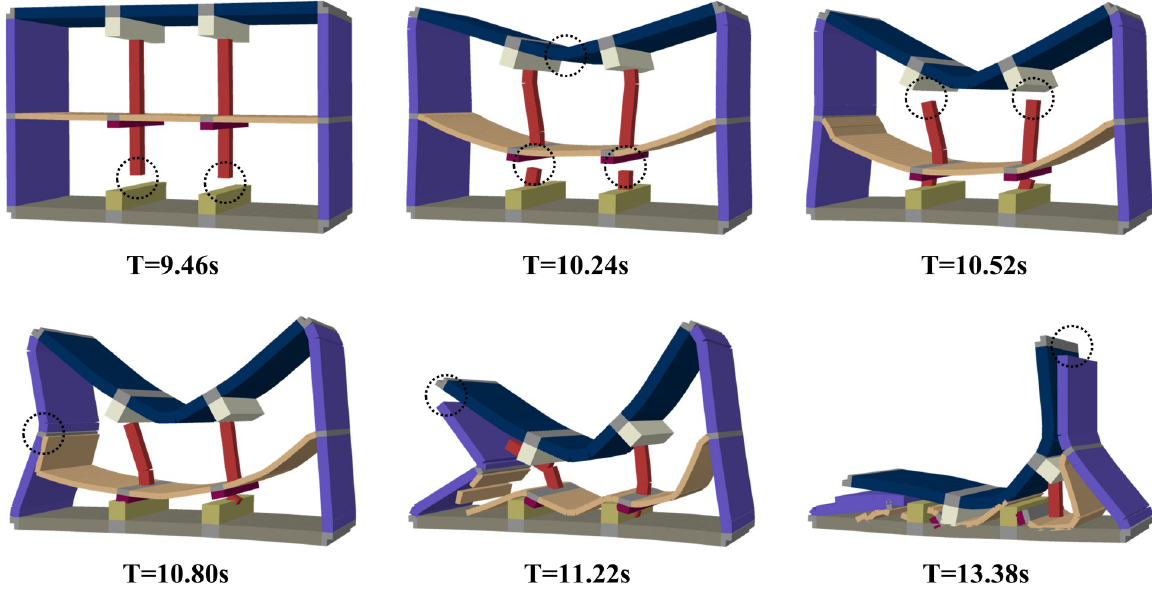
Fig 17. Collapse process of the subway station structure. deformation. Subsequently, the plates that lost vertical support begin to suffer downward set- tlement under self-weight and overburden loads, and apparent bending deformation is observed in the middle span of the top plate. Then, the fractured bottom columns hit the bot- tom plate, while the severely damaged top sections ultimately fail, which causes both bottom columns to be separated from the main structure at 10.24 s. With the top plate continuously sinking, the top section of the top columns also fails under massive deformation at 10.52 s. The top plate completely loses vertical support, which aggravates its bending deformation. Further- more, bending failures are observed likewise at the joint areas between sidewalls and middle plates at 10.80 s. Afterwards, the joint areas between sidewalls and top plates are damaged at 11.22 s as the bending angle of sidewalls continuously increases, after which the top, middle, and bottom plates of the left half of the structure entirely overlap due to the loss of vertical sup- port. The right half leaves only a small amount of space under the support of the remaining part of the sidewall and top plate. At 13.38 s, the structure completely collapses, as shown in Fig 17. The damage process and failure pattern of the station structure have some similarities with the well-known case of the Daikai station. For example, both stations’ collapse starts with col- umn failures, leading to the bending of upper plates and roofs. However, significant differences also exist between the two cases. For the station structure in the proposed study, severe bend- ing damages are observed in the middle of the sidewalls, which were not reported in the seis- mic damage investigations of the Daikai station [2]. This is speculated to be associated with the fact that the sidewall height in this study is relatively higher, resulting in a more significant seismic load and bending deformation on the sidewalls compared to that of the Daikai station. At the same time, the plates that lost vertical support settle downward and bend after the fail- ure of the bottom columns, resulting in the loss of original horizontal support to the sidewalls. Moreover, the bended plates induce inward loads on the sidewalls, which further aggravates the bending damage. This explains the reason that the sidewall bending damage occurs near the position where they are connected with the plate components. The damage process under other analysis conditions is similar and will not be described and discussed here.